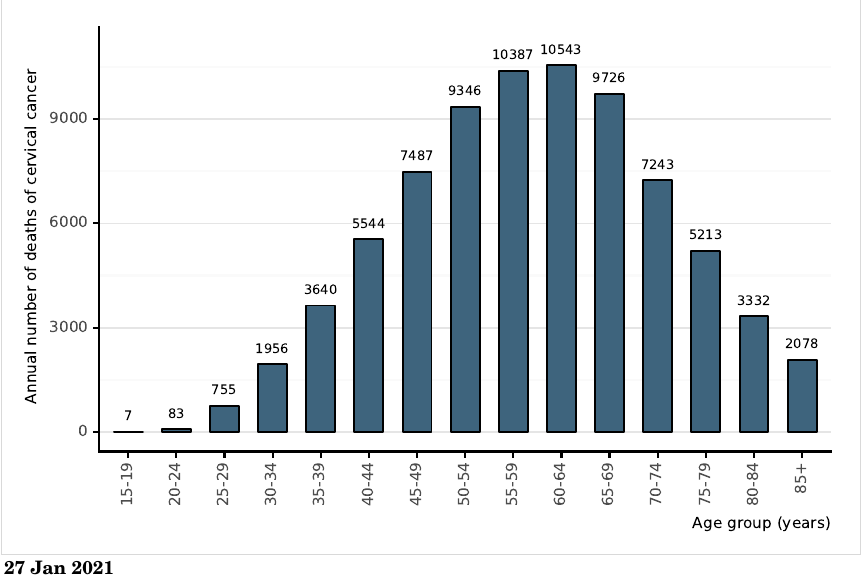
Figure 12: Annual number of deaths of cervical cancer in India (estimates for